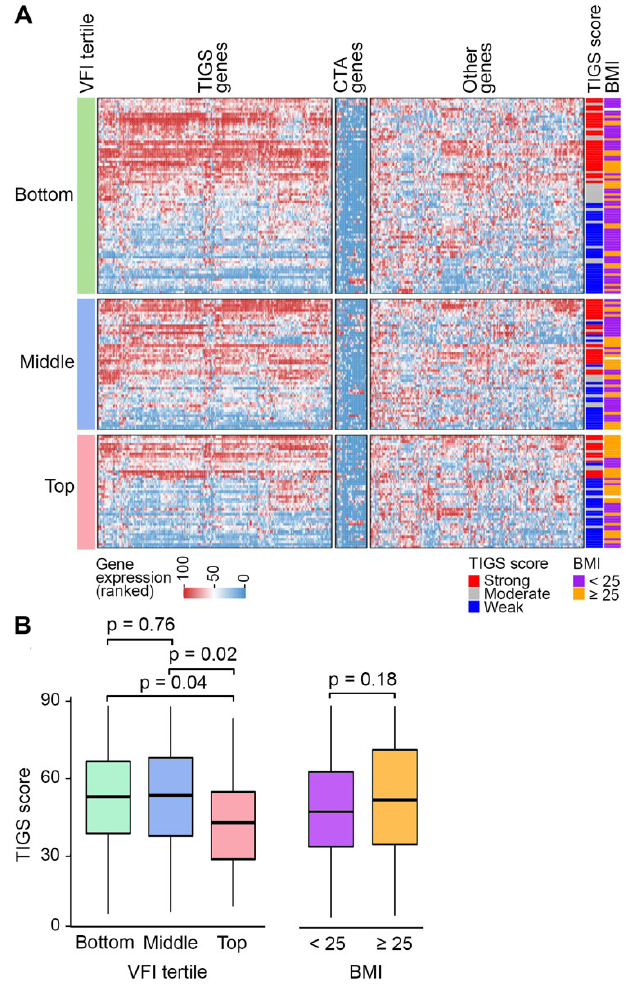
Figure 5. Visceral obesity may attenuate tumor immunogenicity in non-small cell lung cancer. Ranked gene expression measurements of tumors of 175 patients were examined by unsupervised hierarchical clustering to discover three clusters followed by k-means clustering (k = 3). Joint expression of the cluster of tumor immunogenicity signature (TIGS) genes was summarized as TIGS score. ( A ). Tumor gene expression heatmap of the 175 subjects grouped into tertiles using visceral fat index (VFI) as the visceral obesity metric. The three gene clusters include one for 161 TIGS and another for 17 cancer/testis antigen (CTA) genes, and the heat map is annotated with categorized body mass index (BMI) and TIGS score (strong, >61; moderate, 43–61; weak, <44). ( B ). Boxplots of TIGS scores of patients of different VFI and BMI categories. Median, inter-quartile range, and minimum and maximum values of non-outliers are depicted. Wilcoxon rank sum test p values are